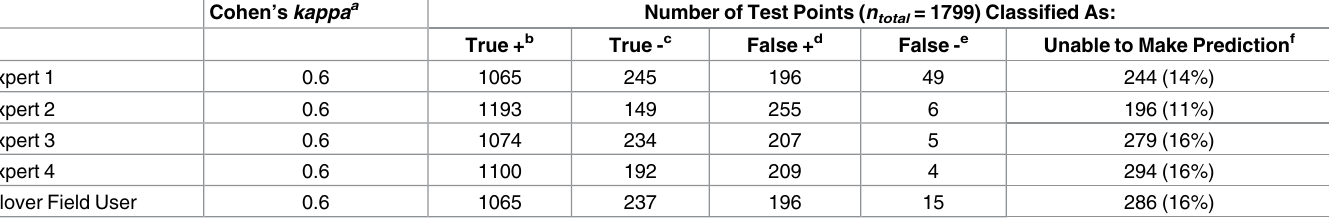
Table 4. Skill of Bayesian networks used to predict piping plover habitat suitability when trained with data points ( n = 181) classified separately by four subject-matter experts and by an iPlover user in the field. Modelswere used to predict nest presence/absencebased on the habitatcharacteris- tics of 1799 iPlover points collected in 2014 and 2015. Skill was assessed through Cohen’s kappa (0 = poor performance, 1 = perfect